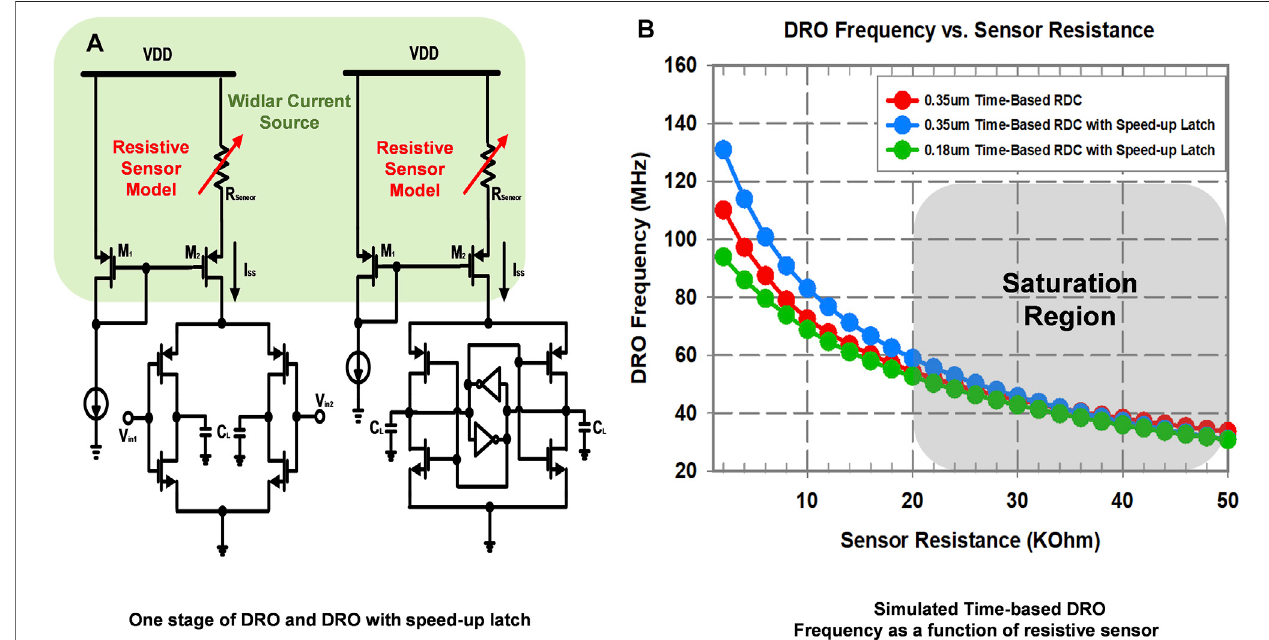
FIGURE 6 | Simulation results for the time-based RDC: (A) one stage of the DRO and DRO with the speed-up latch for analysis of R sensor range and circuit design and (B) DRO frequency as a function of R sensor .